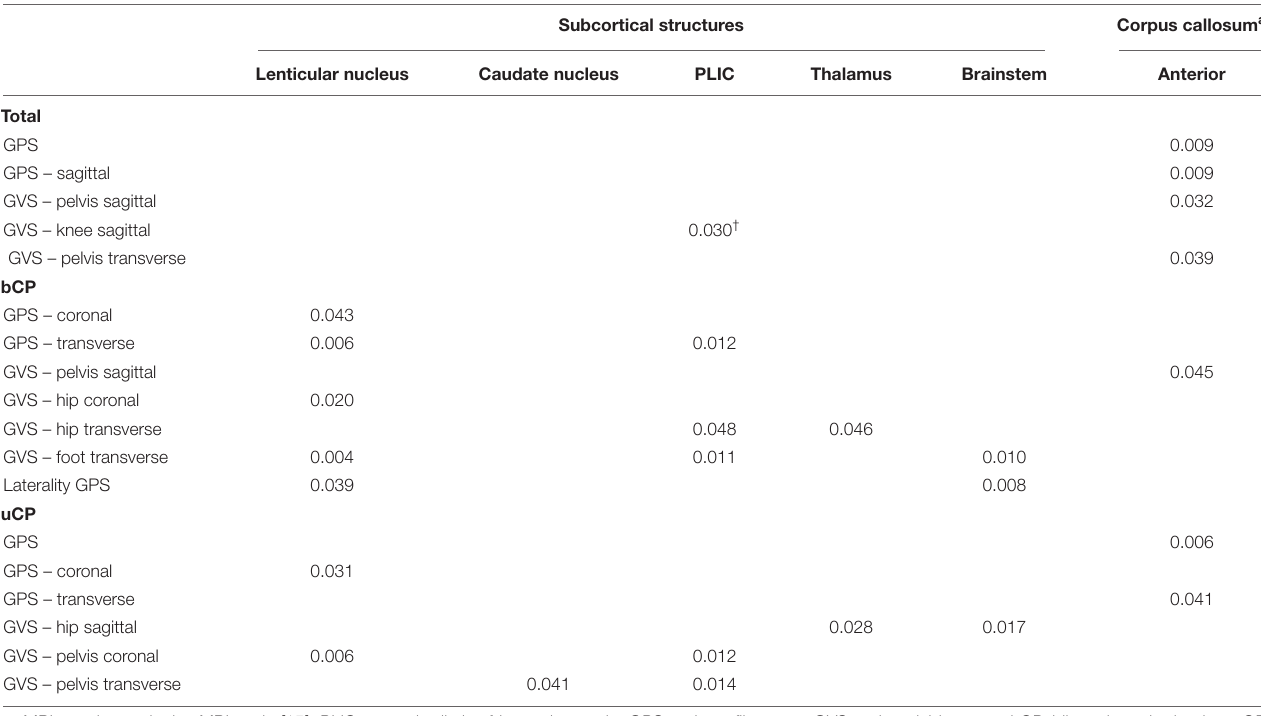
TABLE 4 | Statistically significant differences based on Mann–Whitney U test between the continuous gait scores for the total ( N = 104), bilateral ( n = 52), and unilateral ( n = 52) groups for the dichotomous sqMRI scores.